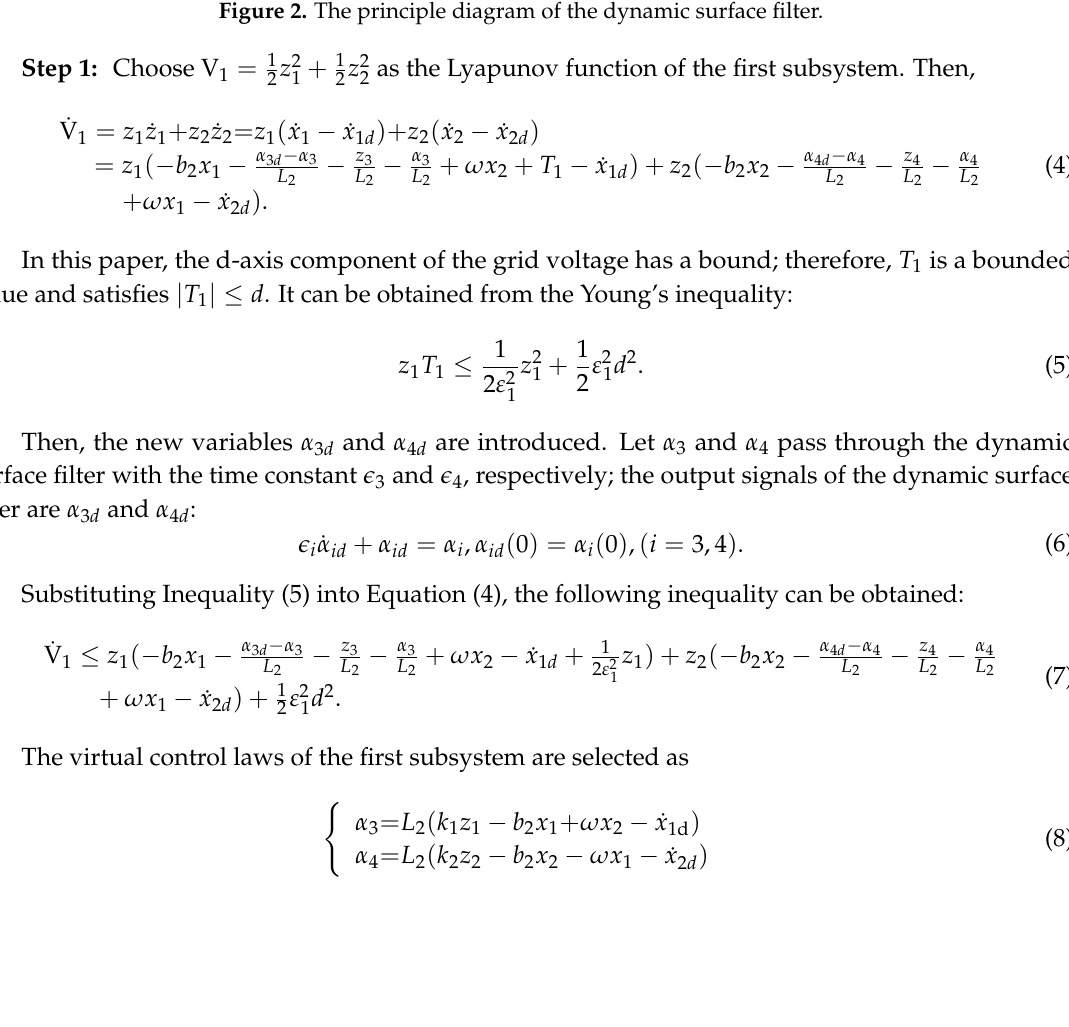
Figure 2. The principle diagram of the dynamic surface